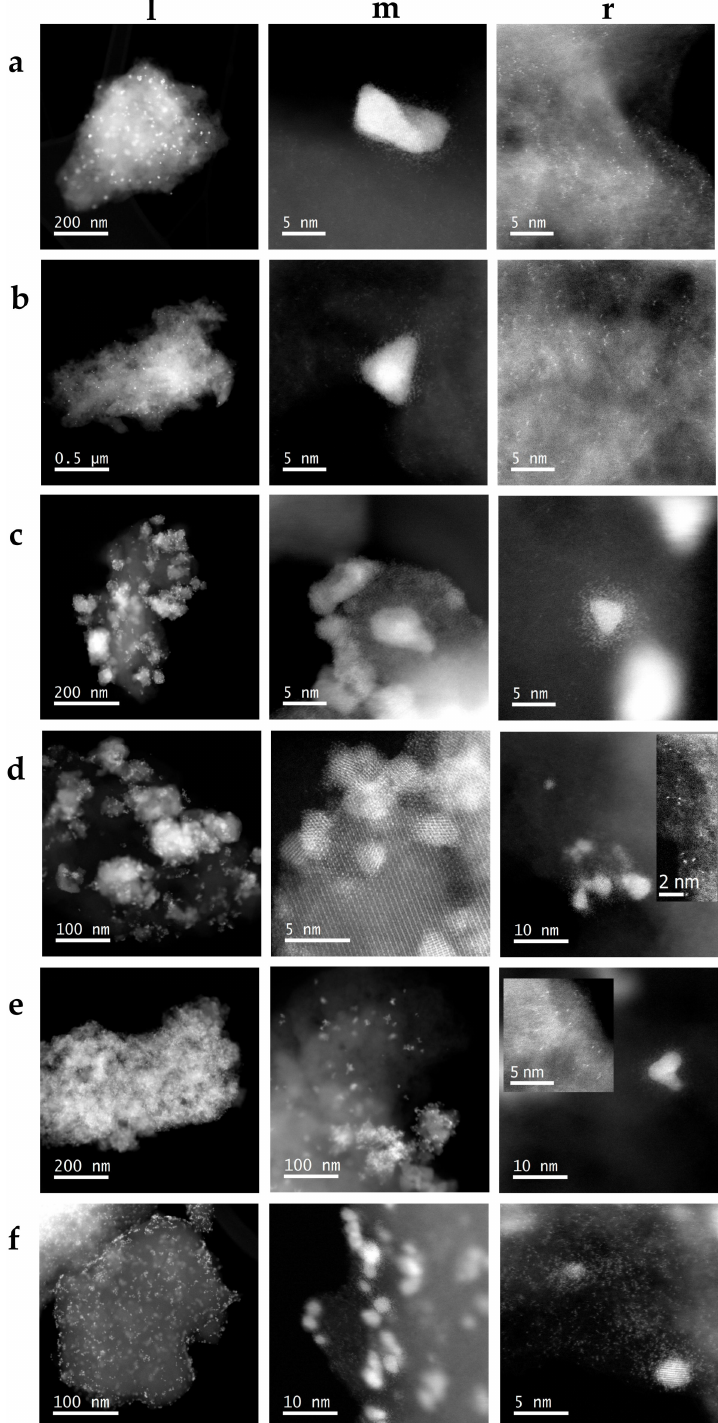
Figure 2. STEM-HAADF micrographs of catalysts exposed to UV-vis irradiation with TEOA: ( a ) Pt/CN for 3 h, ( b ) Pt/CN for 20 h, ( c ) Pt/10AIS-CN for 3 h, ( d ) Pt/10AIS-CN for 20 h, ( e ) physical mixture Pt/(10 wt.% AIS + CN) for 20 h and ( f ) Pt/CN after 4 h with oxalic acid (OA) as sacrificial agent. Plots l, m and r show areas of the same sample with different